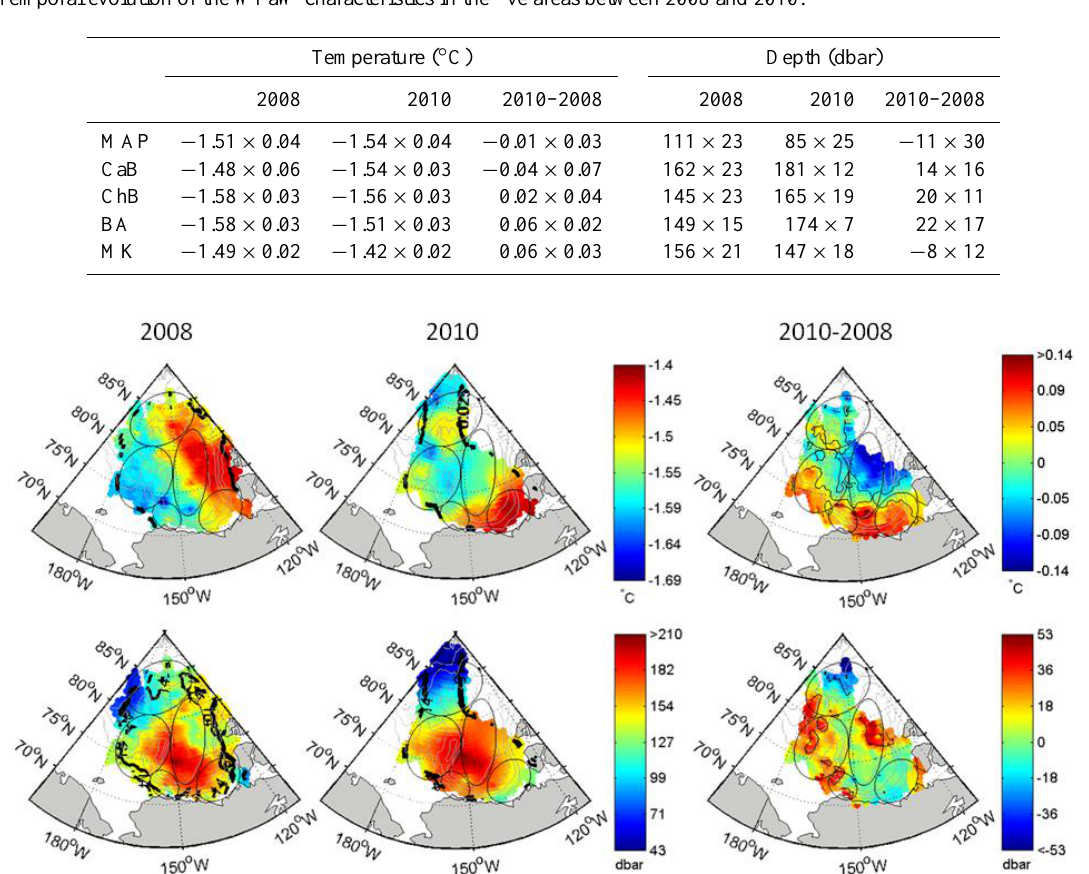
Figure 9: Kriging interpolation of the WPaW temperature (T , top) and the depth level WPaW Fig. 9. Kriging interpolation of the WPaW temperature ( T WPaW , top) and the depth level ( Z WPaW , bottom), for years 2008 (left panel) (Z , bottom), for years 2008 (left panel) and 2010 (middle panel), and the evolution WPaW and 2010 (middle panel), and the evolution between the two years (right panel). In the left and middle panels, thick black dashed isolines between the two years (right panel). On the left and middle panels, thick black dashed isolines correspond to estimation error ( σ) due to Kriging interpolation process. The isolines represented are σ = 0.021 ◦ C and σ = 0.025 ◦ C for correspond to estimation error (σ) due to Kriging interpolation process. The isolines T WPaW , and σ = 14dbar and σ =15dbar for Z WPaW . I n the right panel, thin black isolines correspond to 95% significance. represented are σ = 0.021°C and σ = 0.025°C for T , and σ = 14 dbar and σ = 15 dbar for WPaW Z . On the right panel, thin black isolines correspond to 95% significance. WPaW of Rabe and Wisotzki (2010) for the 2006–2008 time period with H FW reaching more than 25 m in the Beaufort Gyre and minimum values (between 6 m and 13 m) encountered in the western